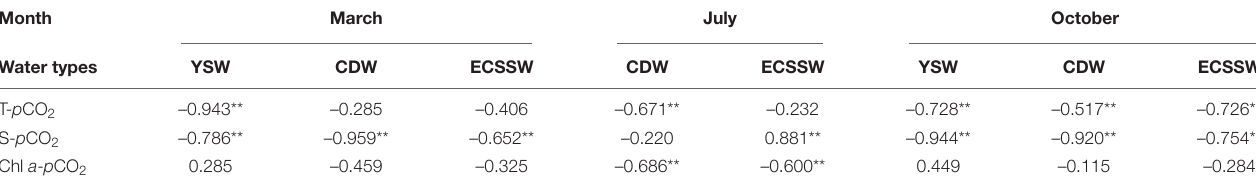
TABLE 2 | Pearson correlations of p CO 2 and potential drivers (T, S, and Chl a ) in March, July, and